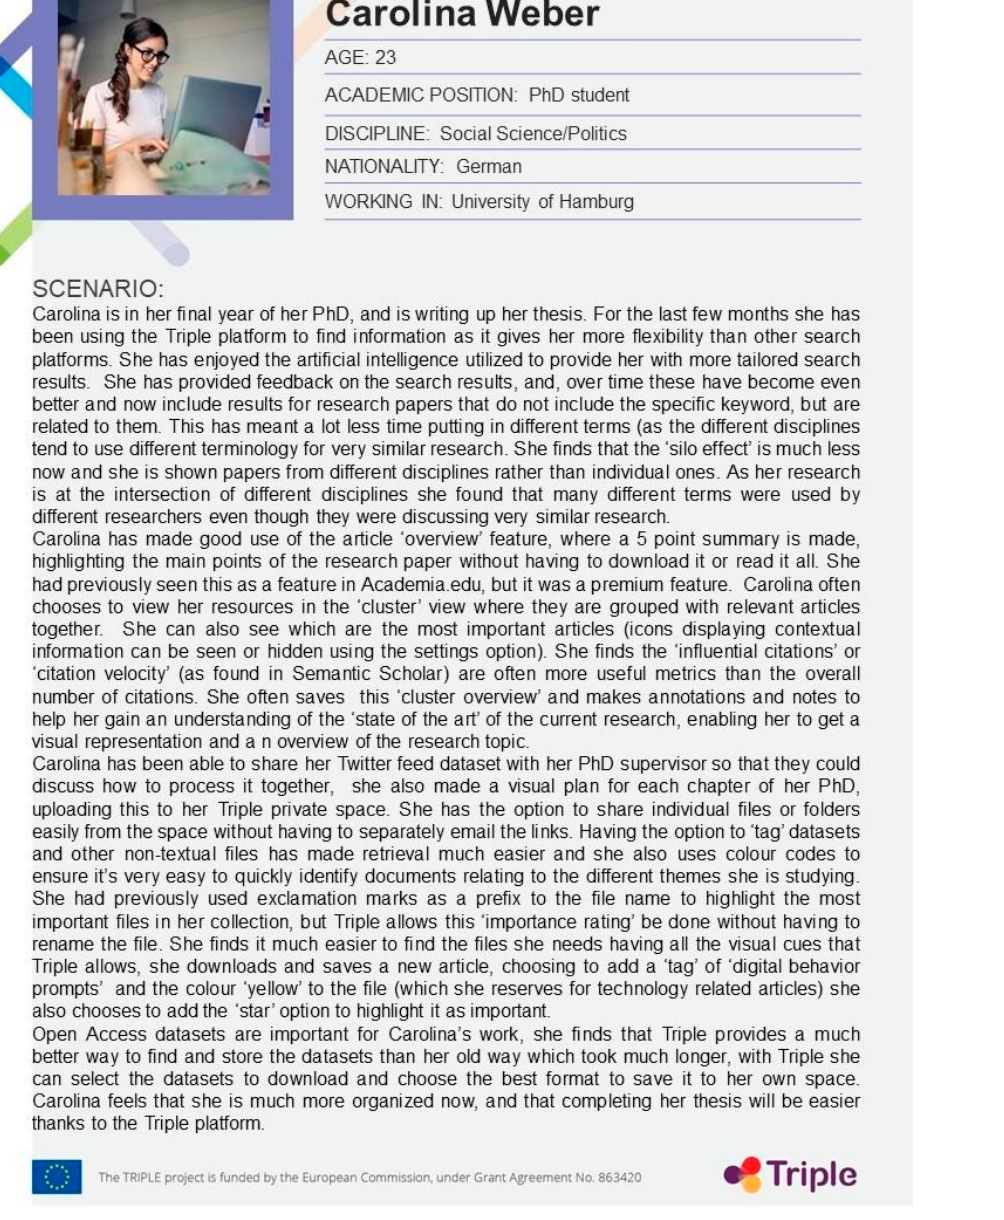
Figure 7. Example of an academic scenario created from the results of the requirements analysis.